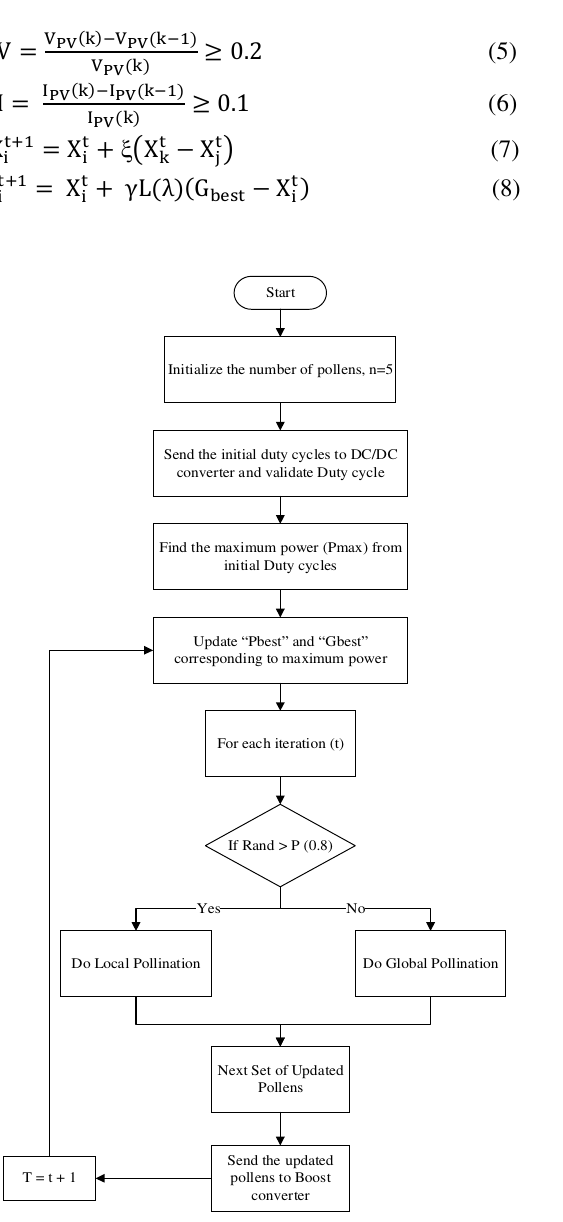
FIG. 3. FLOWCHART OF FPA